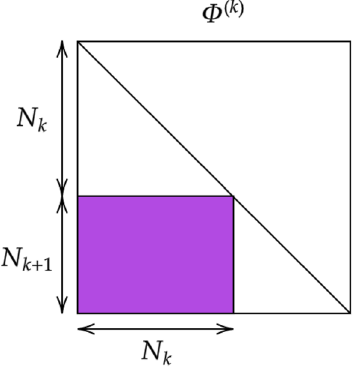
k ) is schematically